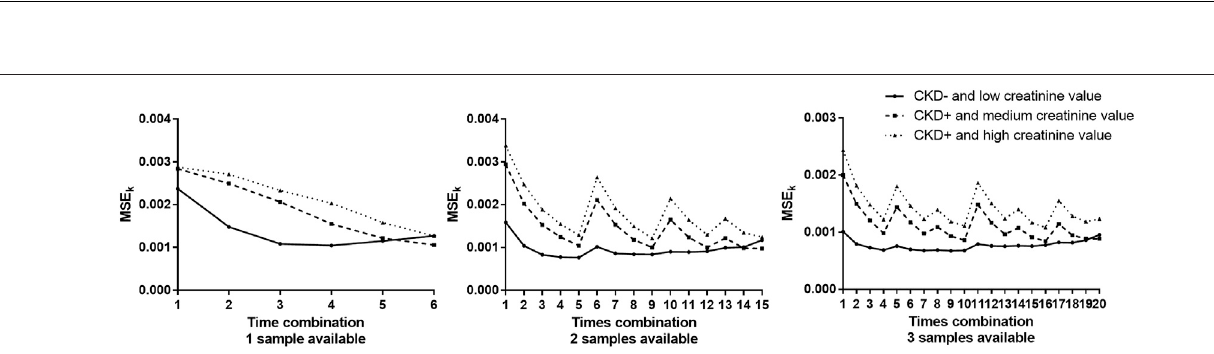
Frontiers in Pharmacology |